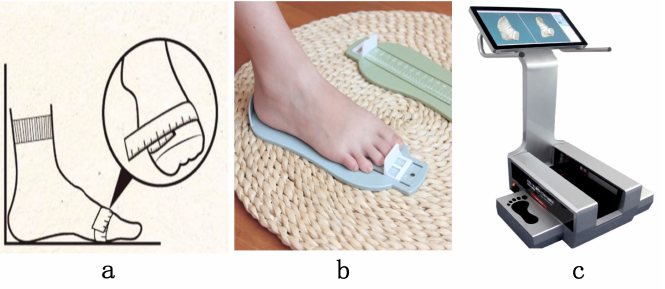
Figure 1. Foot data acquisition method. ( a ) Ruler; ( b ) Foot measuring device; ( c ) Foot